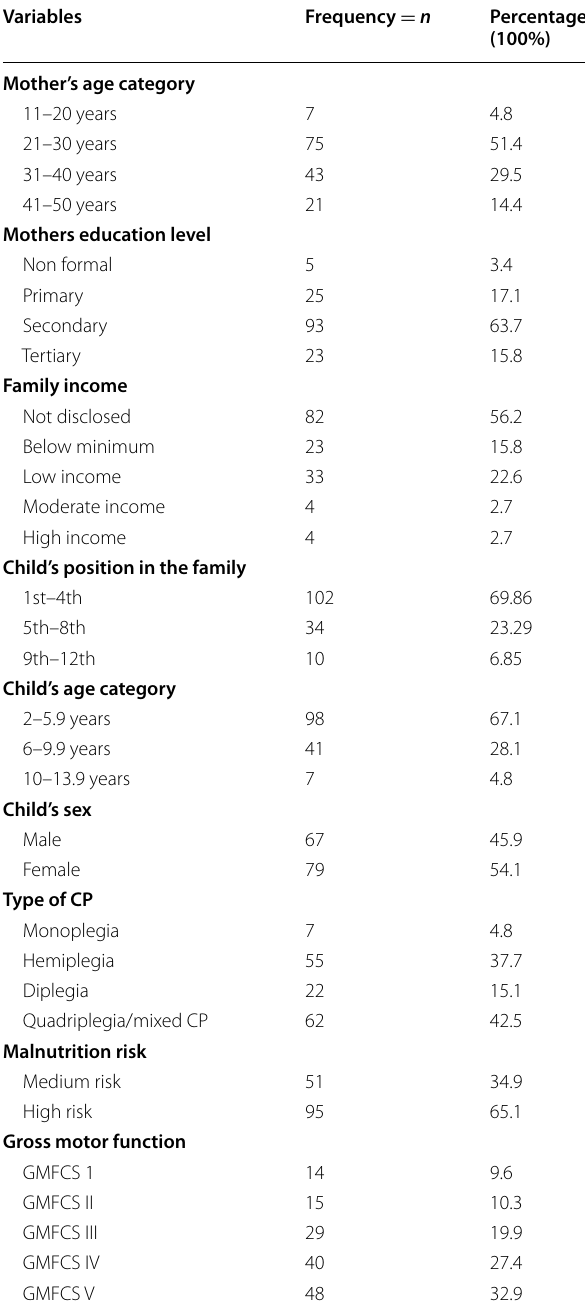
Table 1 Sociodemographic characteristics of the study